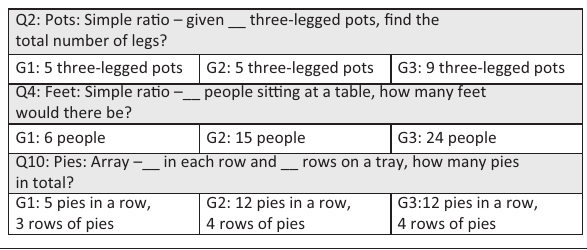
FIGURE 4: Simple direct ratio multiplication problems.